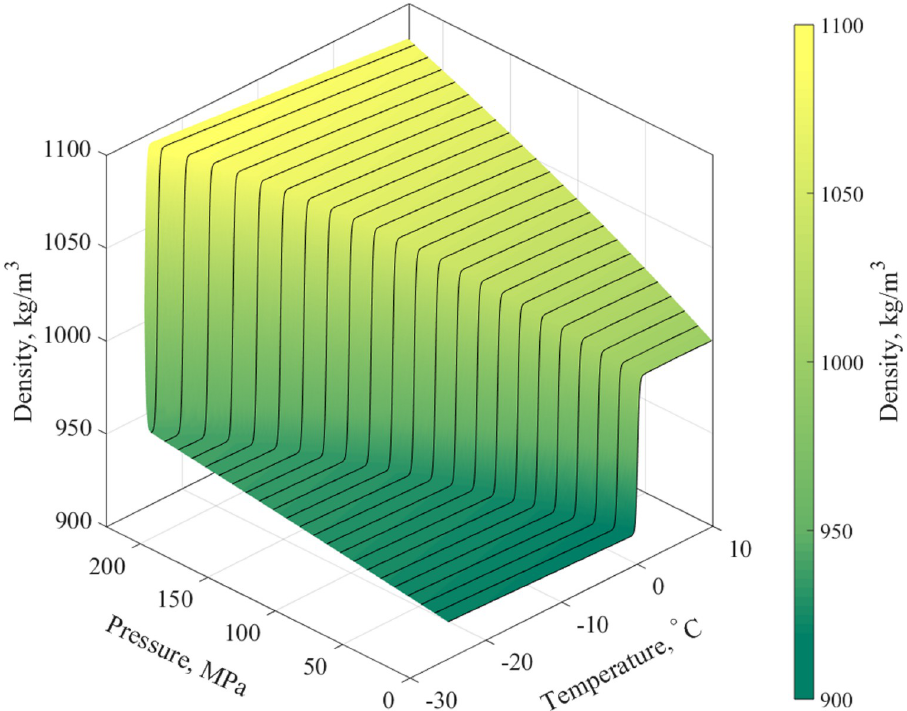
Fig 4. Water density. Density of water within the range of pressures and temperatures investigated in the current study, as calculated by Eq